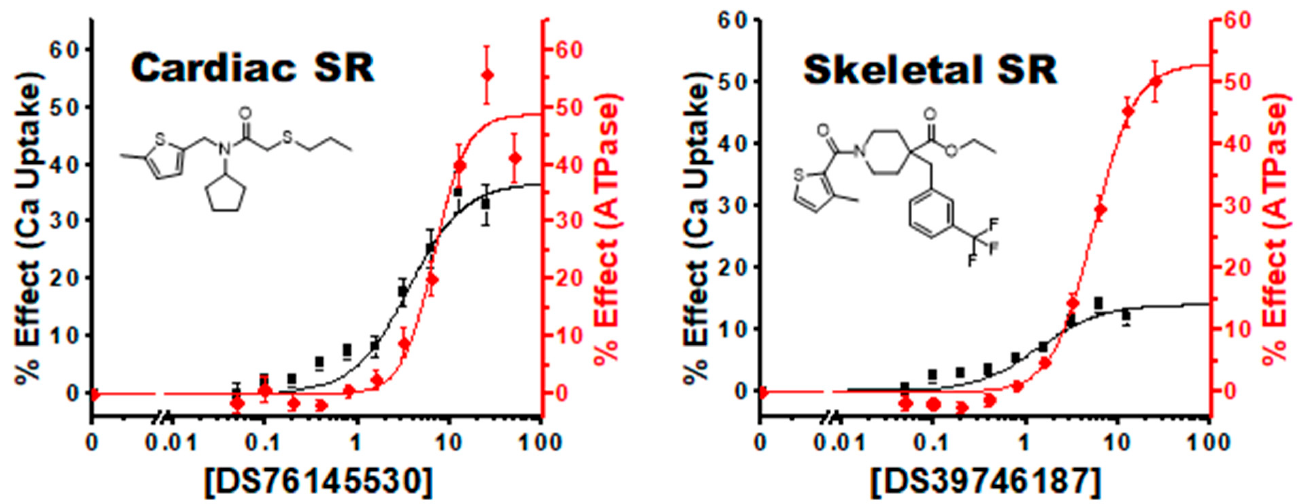
Figure 5. ImprovedCouplingCompounds: Concentrationresponsecurvesofcompounds#3(DS76145530) in cardiac SR and #8 (DS39746187) in skeletal SR show a percent increase in Ca 2+ uptake activity that precedes the ATPase effect indicating improved coupling efficiency between the two SERCA enzymatic activities. n = 3, ±